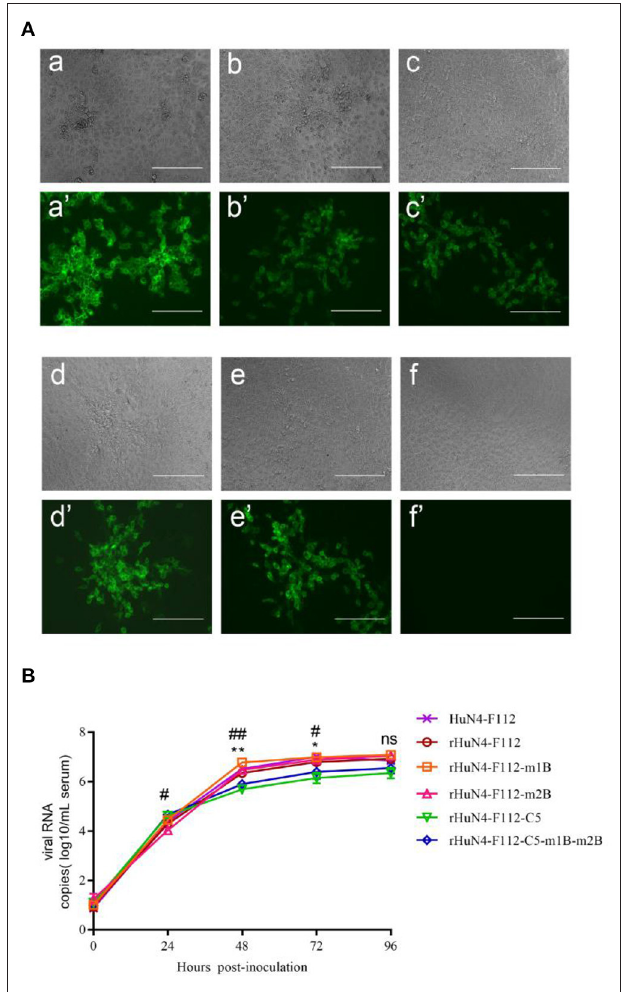
FIGURE 6 | Characterization of PRRSV m1B and m2B deletion mutants. (A) CPE and bright fluorescence of deletion-marker strains and parental PRRSV-infected MARC-145 cells. a, rHuN4-F112-m1B; b, rHuN4-F112-m2B; c, rHuN4-F112-C5-m1B-m2B; d, rHuN4-F112; e, rHuN4-F112-C5; f, mock. Bar: 200 µ m. (B) Growth curves of the parental virus and deletion mutants in Marc-145 cells. Values represent the average of three independent experiments. Error bars indicate standard deviations. Significant differences between the rHuN4-F112-m2B and parental virus are indicated ( # P < 0.05, ## P < 0.01); significant differences between the rHuN4-F112-m1B and parental virus are indicated (* P < 0.05, ** P < 0.01).